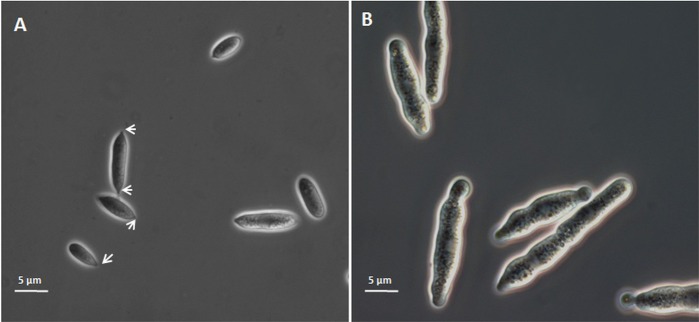
Pseudozyma flocculosa sporidia in phase contrast microscopy.A: aerial sporidia (AS) obtained by solid-state fermentation, exhibiting one or two apiculate hilum (asterisks). B: submerged sporidia (SS) obtained by liquid-state fermentation, regularly showing protrusion bulging and inclusions, Arrows point to the apiculate hilum of the AS.